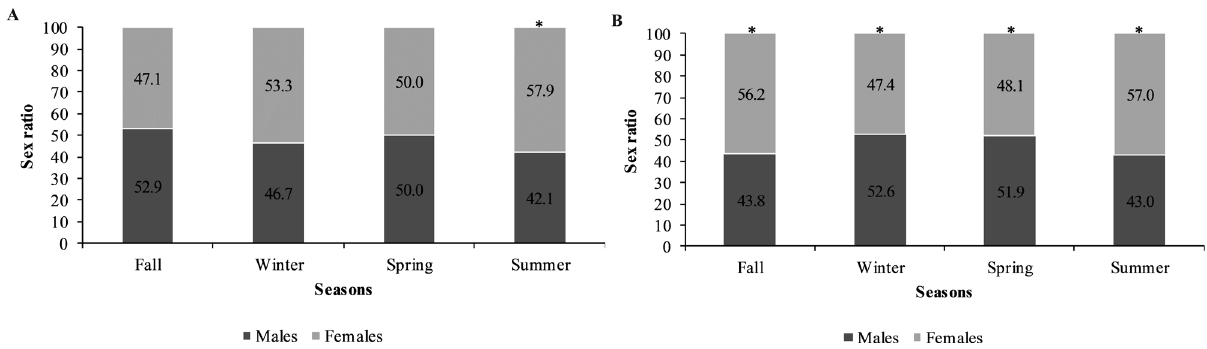
Figure 4. Seasonal sex-ratio in Hyalella georginae (A) and Hyalella gauchensis (B) , Palmeira das Missões, state of Rio Grande do Sul, Brazil. Asterisks above the columns indicate significant diferences between the proportions of males and females (p < 0.05).